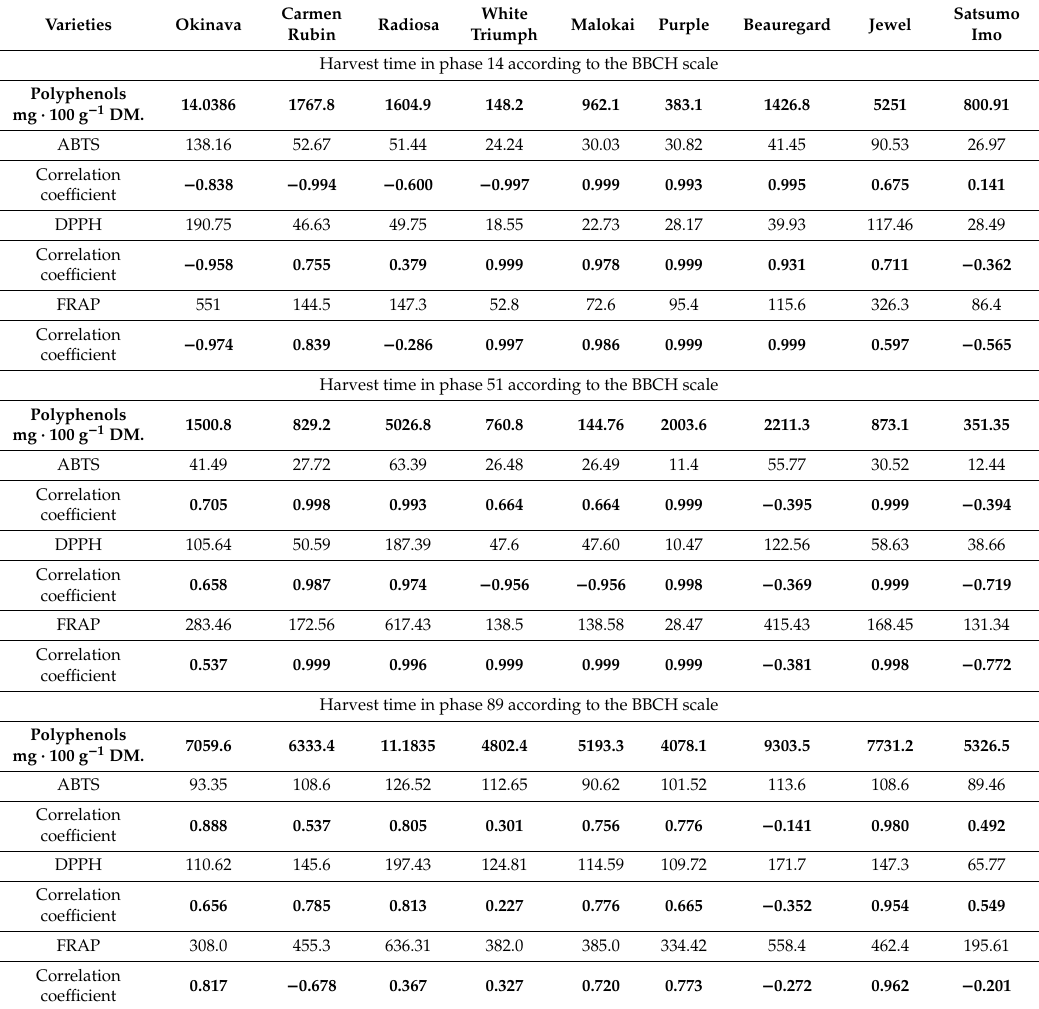
Table 2. Antioxidant activity and correlation coe ffi cients for sweet potato ( Ipomoea batatas L. [Lam.]) leaf extracts measured by tests ABTS o + , FRAP and DPPH [ µ mol TE (Trolox) / 100 g -1 DM.].